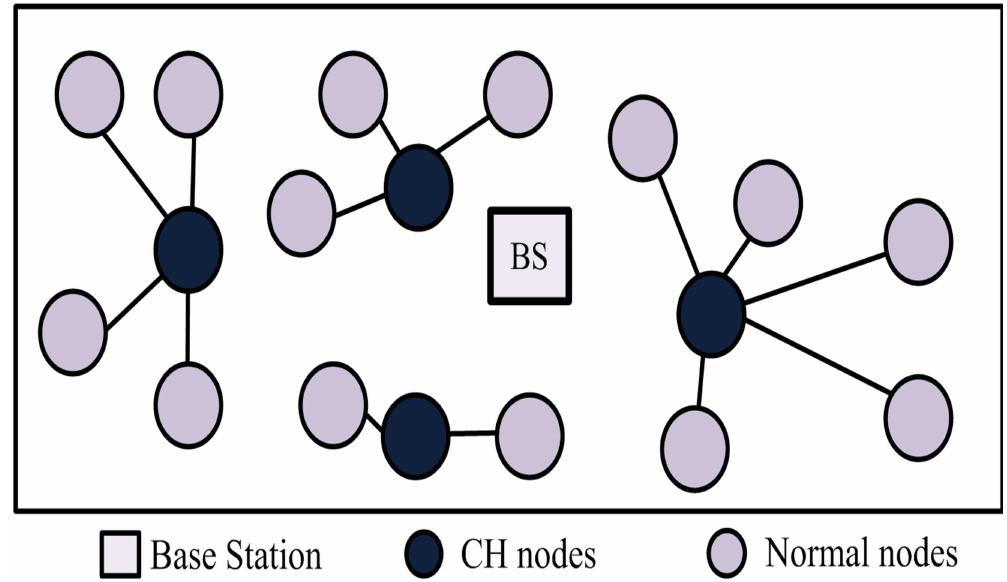
Fig 1. Node deployment in the